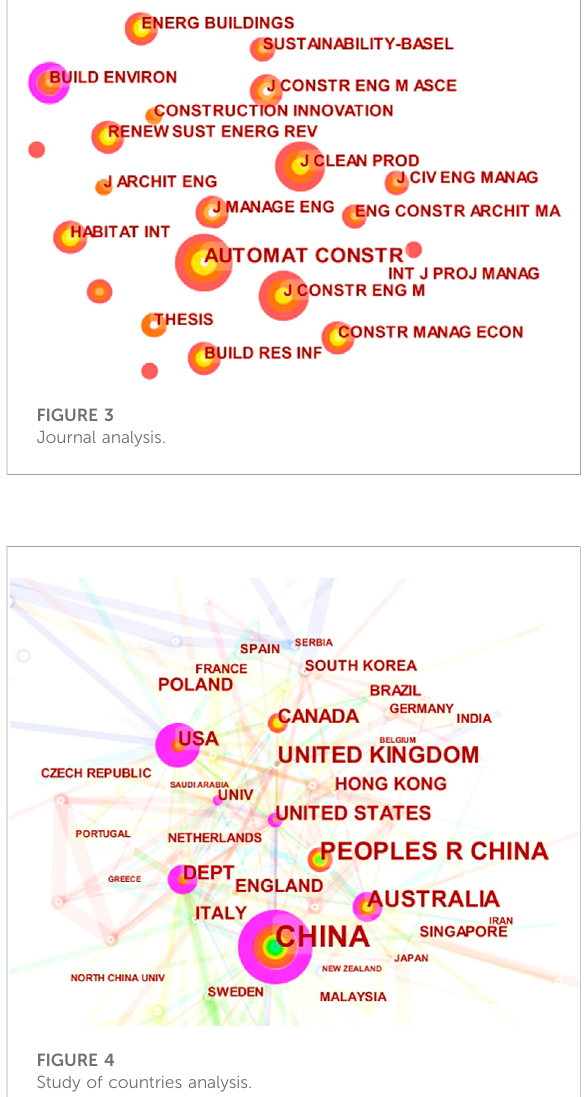
FIGURE 4 Study of countries